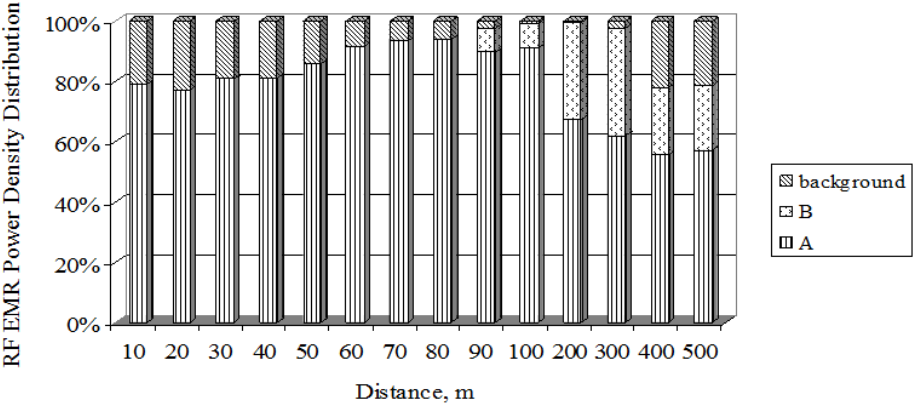
Figure 12. Contributions of different antenna types to the total exposure.